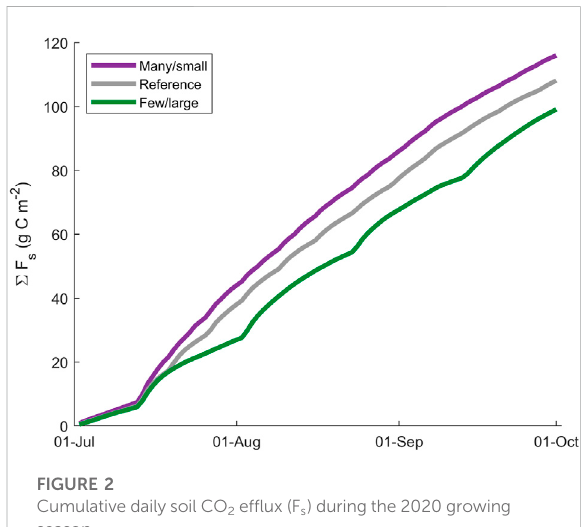
FIGURE 2 Cumulative daily soil CO 2 ef fl ux (F s ) during the 2020 growing season.